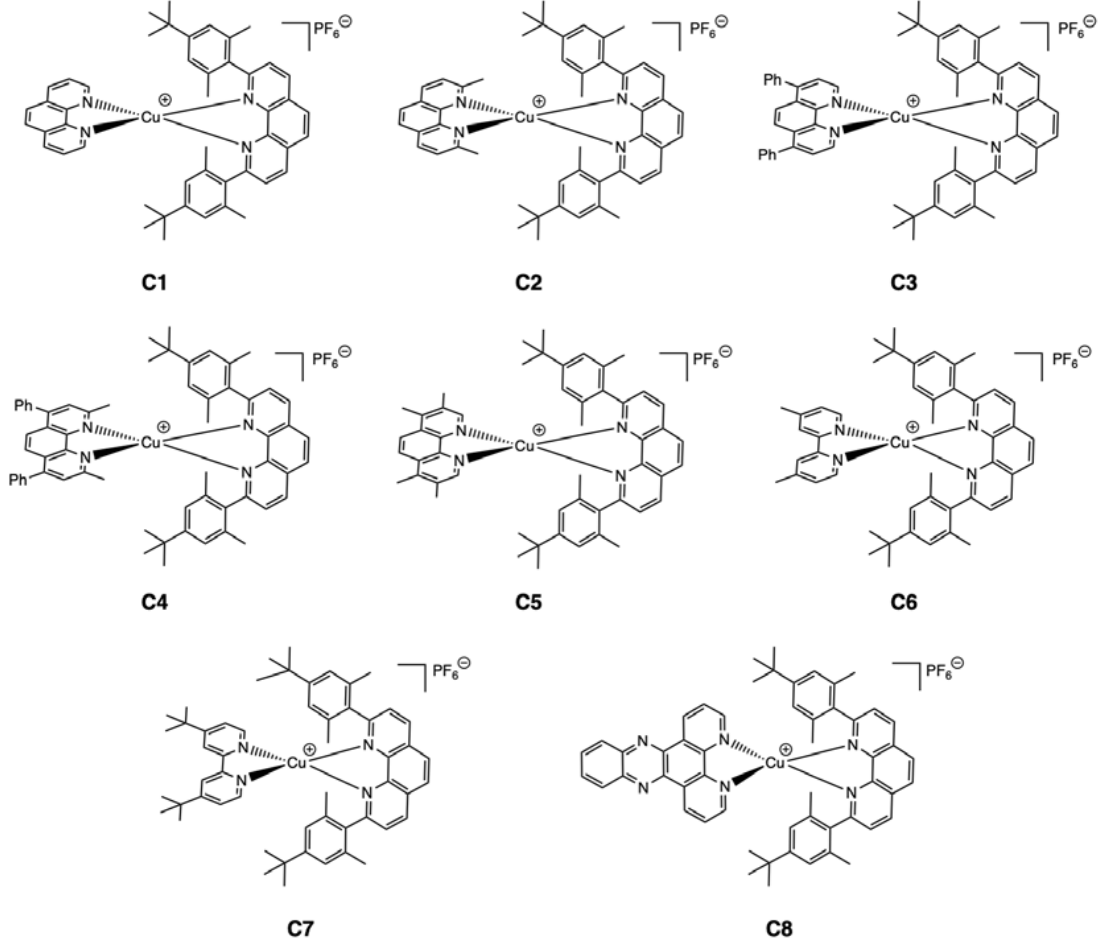
Figure 1. Eight heteroleptic copper(I) diimine complexes ( C1 - C8 ).